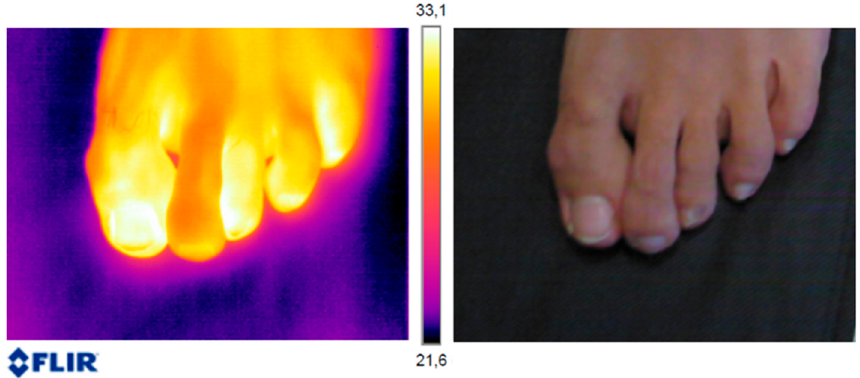
Figure 1. Thermographic image and conventional photo of a participant’s right foot taken with the FLIR E60 BX camera.